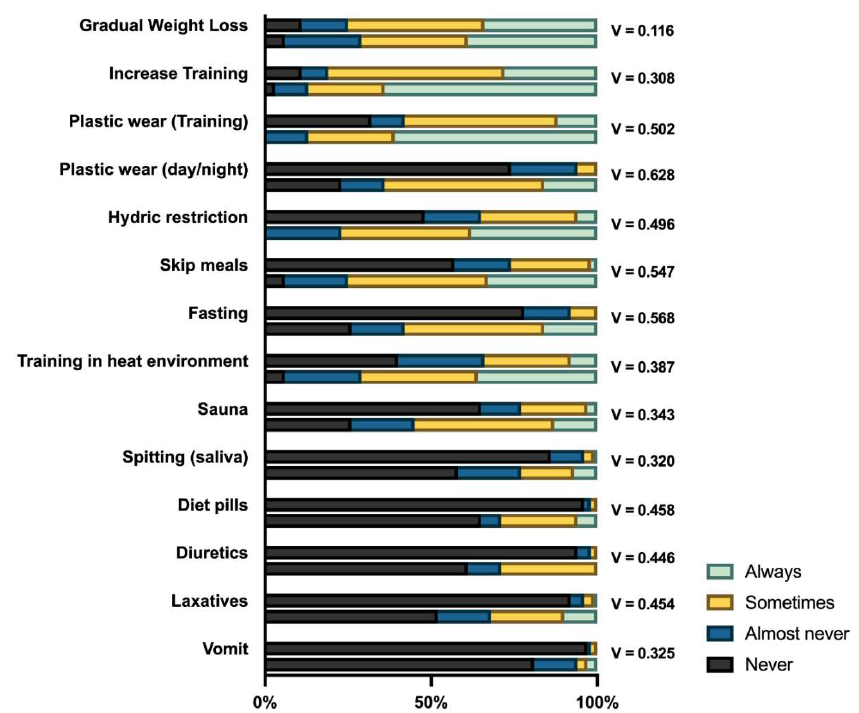
Figure 2. Frequency of use of the different weight-cutting strategies in Cluster 1 (upper bars) and Cluster 2 (lower bars), for each weight-cutting method. Association strength is reported as Cramer’s V.